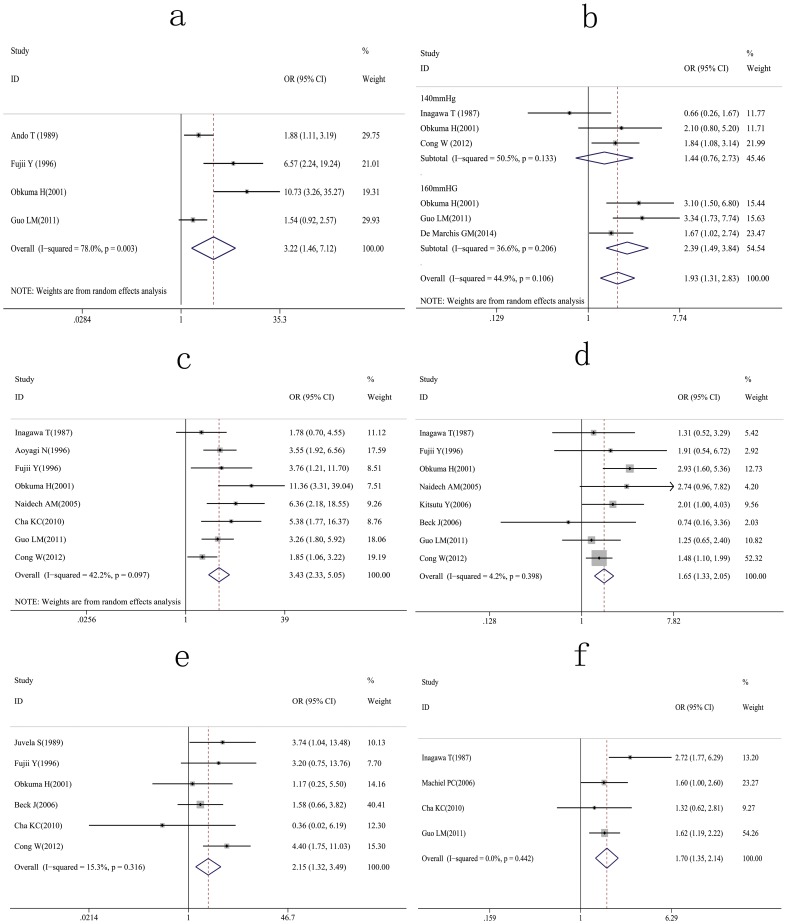
Forest plots for the relation between rebleeding and (a) interval time (<6 h) after initial aSAH; (b) systolic blood pressure; (c) Hunt-Hess grade; (d) intracerebral or intraventricular hematomas; (e) location of aneurysms (posterior vs. anterior circulation); (f) aneurysm size (>10 mm).